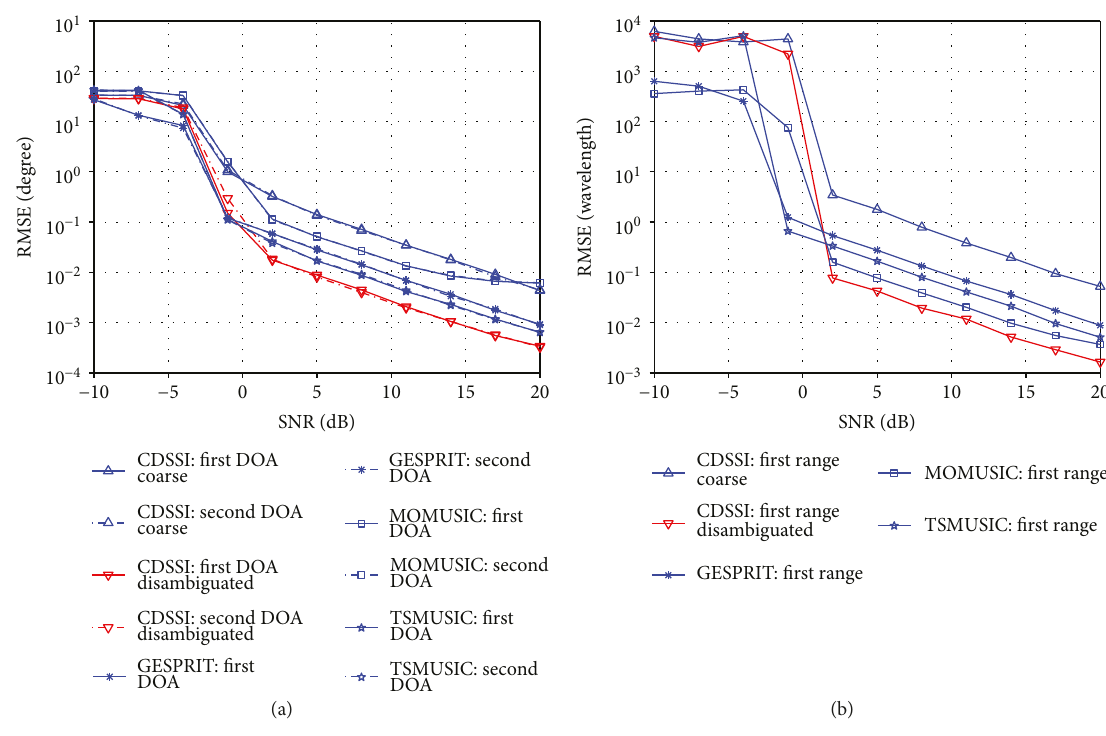
Figure 8: RMSEs of DOA and range estimates versus